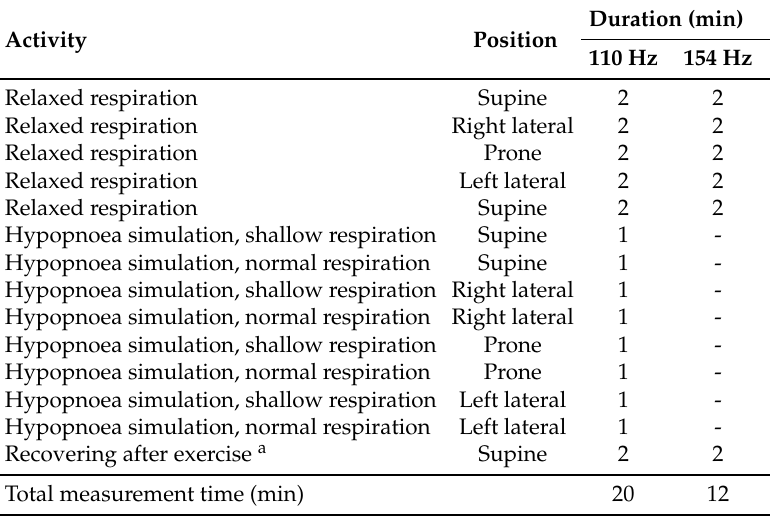
Table 1. Vital sign measurement